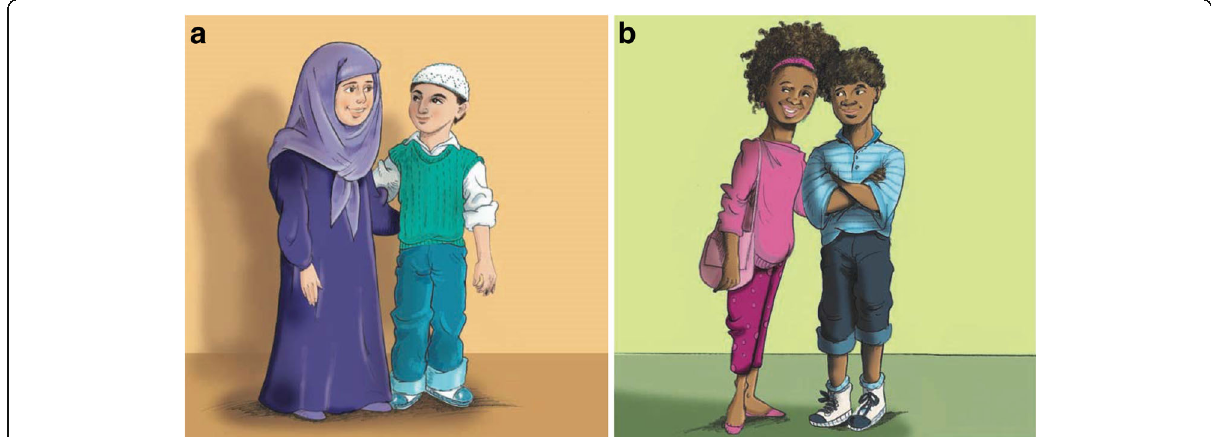
Fig. 1 Pictures used in the questionnaire. Left, Salma and Mustafa (Muslim). Right, Laila and Jamal